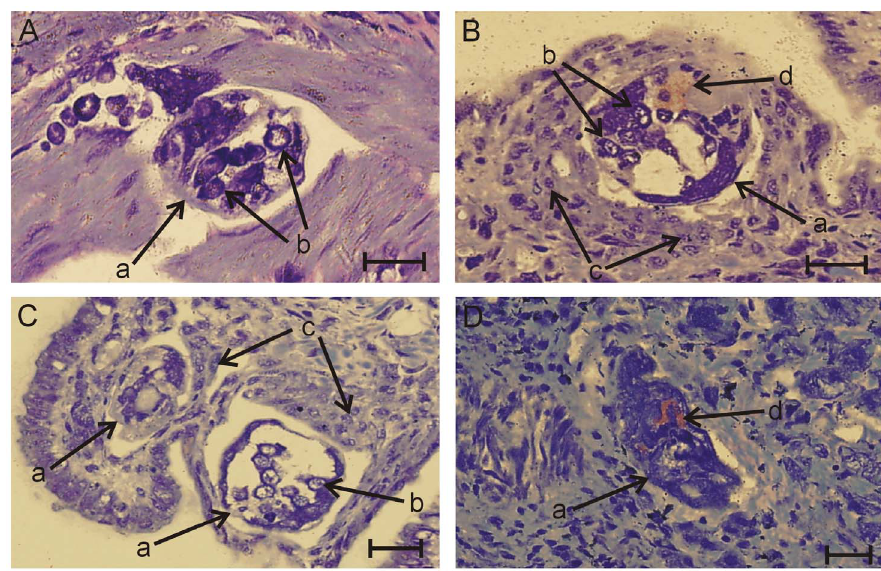
Figure 1. Trichobilharziaregenti larvae within the tissue of Radixlagotis revealed by light microscopy between 1–92 h p.e.; Wright- Giemsa stained sections. (A) Miracidium of T. regenti (a) containing germ cells (b) occurs within the snail tissue without haemocyte infiltration 1 h p.e. (B) and (C) Haemocytes (c) are present in the vicinity of developing T. regenti mother sporocyst (a) 2 and 16 h p.e., respectively; germ cells (b) and gland structure (d) of the parasite are visible. (D) The area around T. regenti mother sporocyst (a) contains no haemocytes 92 h p.e. Gland structure (d) is located in the body of the parasite. Scale bar=20 m m. The images shown are representative of the situation seen in all sections observed during these